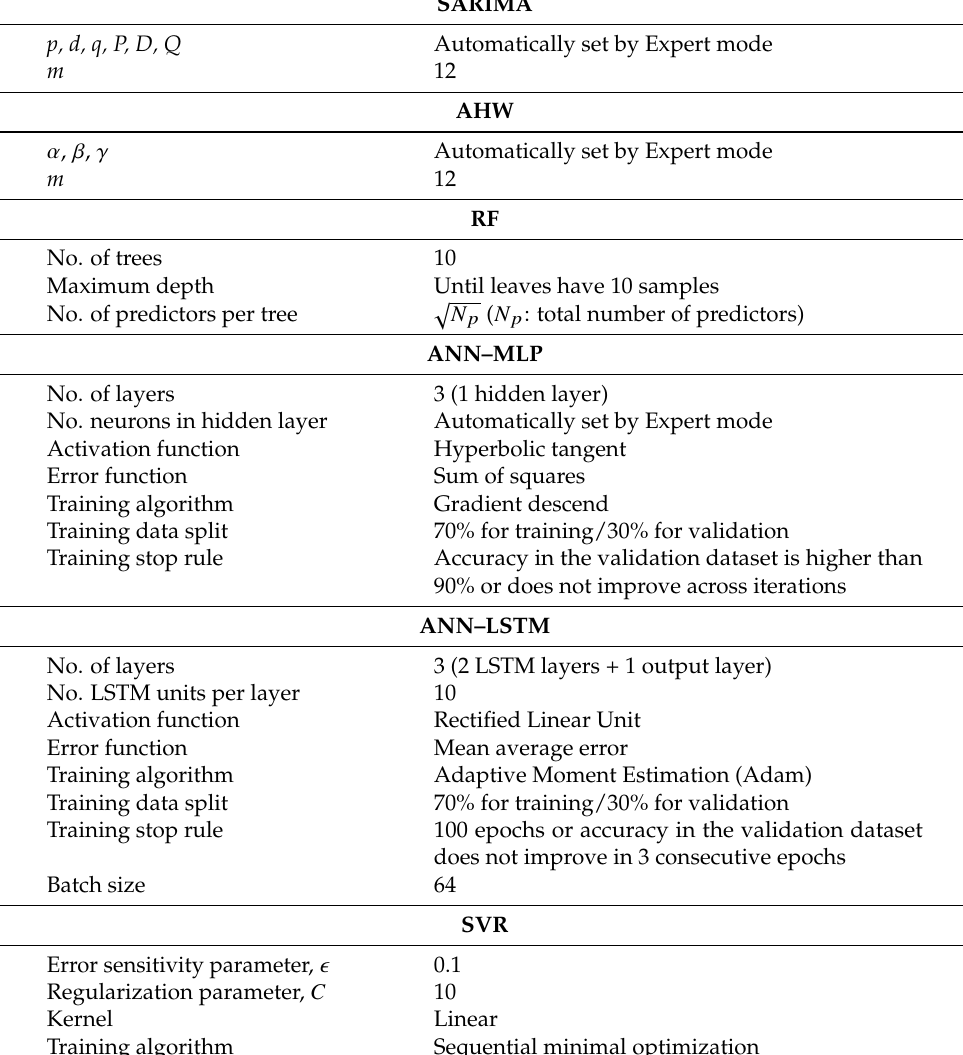
Table 1. Methods of hyperparameter settings.